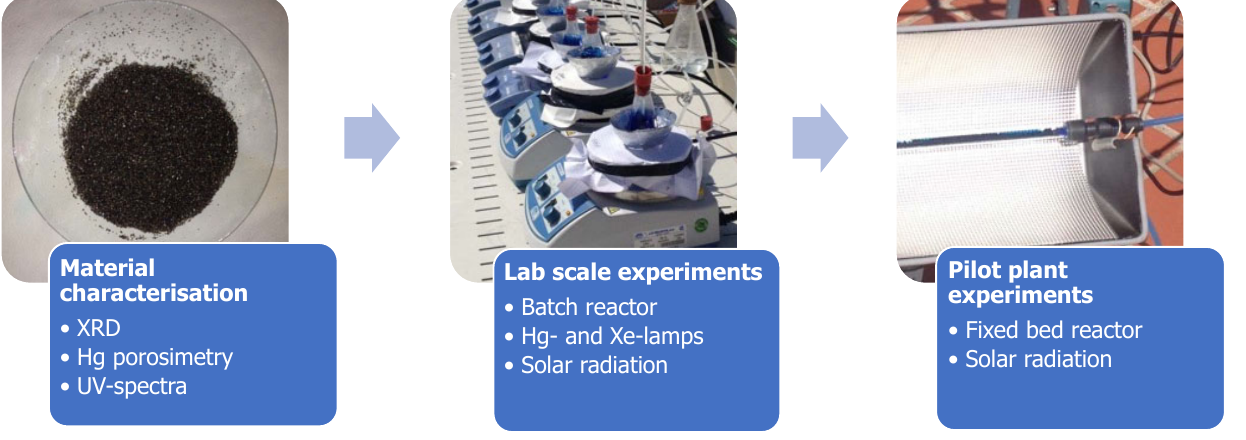
Figure 3. Flow chart of the experimental procedure.